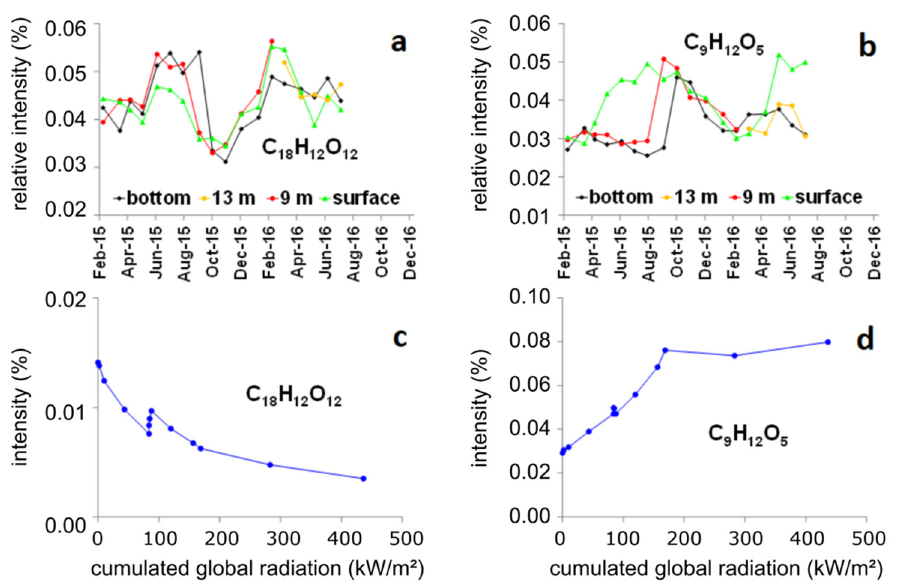
Figure 5. Relative intensities of the degraded group with the MF C 18 H 12 O 12 ( a ) and the photo product C 9 H 12 O 5 ( b ) at the three different depths of the Muldenberg reservoir. ( c , d ) The intensity of these two MFs as a function of the cumulated global radiation in a photodegradation experiment [5].